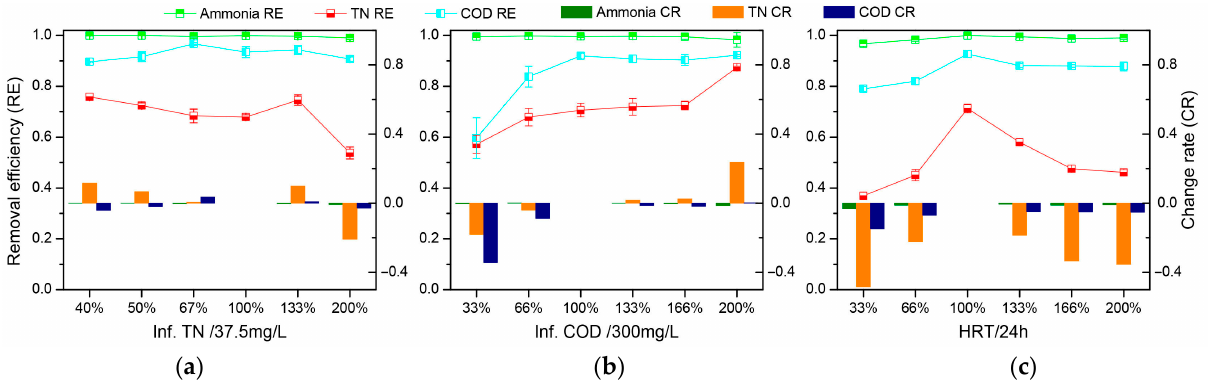
Figure 2. Mean value of the removal e ffi ciency of the WRBC system during the stability testing pe- riod: ( a ) N loads impact; ( b ) COD loads impact; and ( c ) fl ow